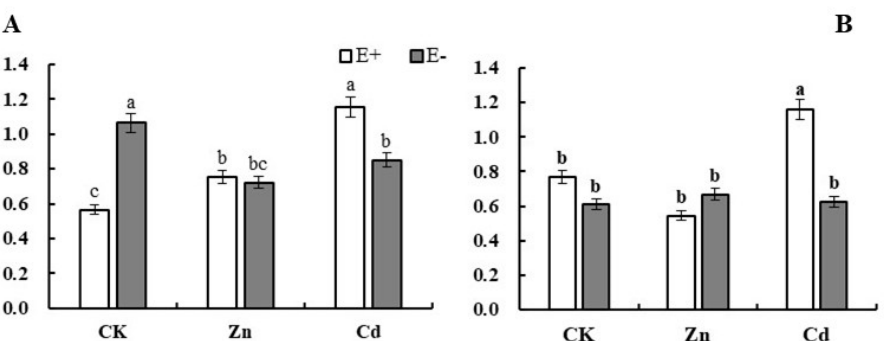
Figure 5. Effect of Epichloë endophytes and Cd 2+ and Zn 2+ treatments on TF values of F. sinensis ; ( A ): TF values of Zn 2+ ions; ( B ): TF values of Cd 2+ ions. Different lowercase letters indicate significant differences between treatments ( p < 0.05).